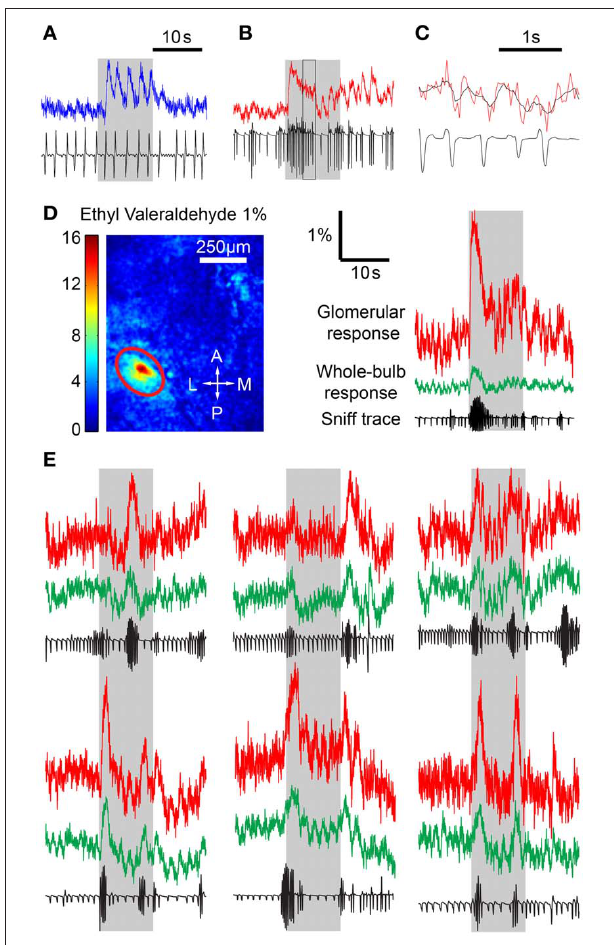
FIGURE 2 | Sniff behavior has an effect on odor responses. (A) Time course of fluorescence in the OB in an anesthetized mouse with corresponding sniff trace, showing individual fluorescence fluctuations in response to a sniff. (B) Awake mouse time course. Individual sniff triggered responses are less easily identified. (C) Expanded version of the boxed region in (B) with the original fluorescence values (red) and a filtered time course (black). Fluorescence signal was filtered to remove high frequency noise. (D) Left, (cid:2) F image from stimulation with 1% ethyl valeraldehyde. Responding glomerulus is circled in red. Right, time course plots from the encircled glomerulus (red) and the whole bulb (green) with corresponding sniff traces. Sniff bursts are correlated with response spikes across the whole bulb, including both responding and non-responding areas, even during clean air delivery. (E) Time courses and sniff traces from awake mice depicting the effect of sniff bursts on glomerular